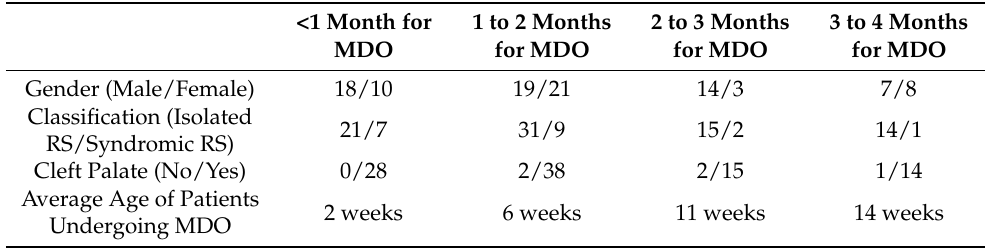
Table 1. Characteristics of